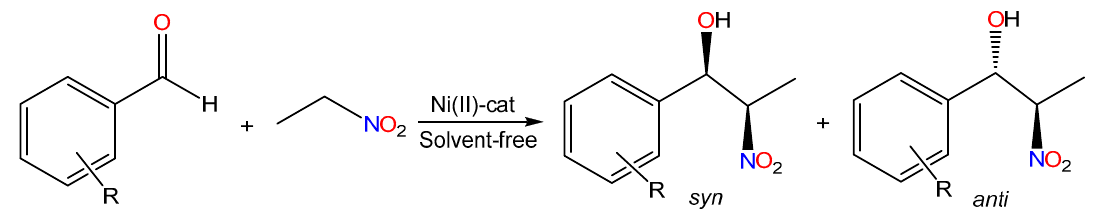
Table 3. Catalytic activity of 1 and 2 in the model nitroaldol condensation reaction a of nitroethane and benzaldehyde.